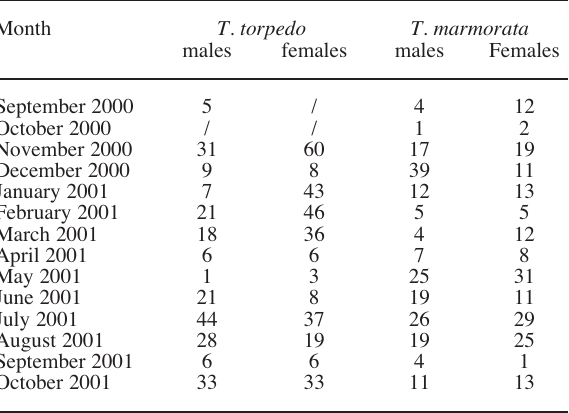
T ABLE 1 . – Monthly samples of T. torpedo and T.